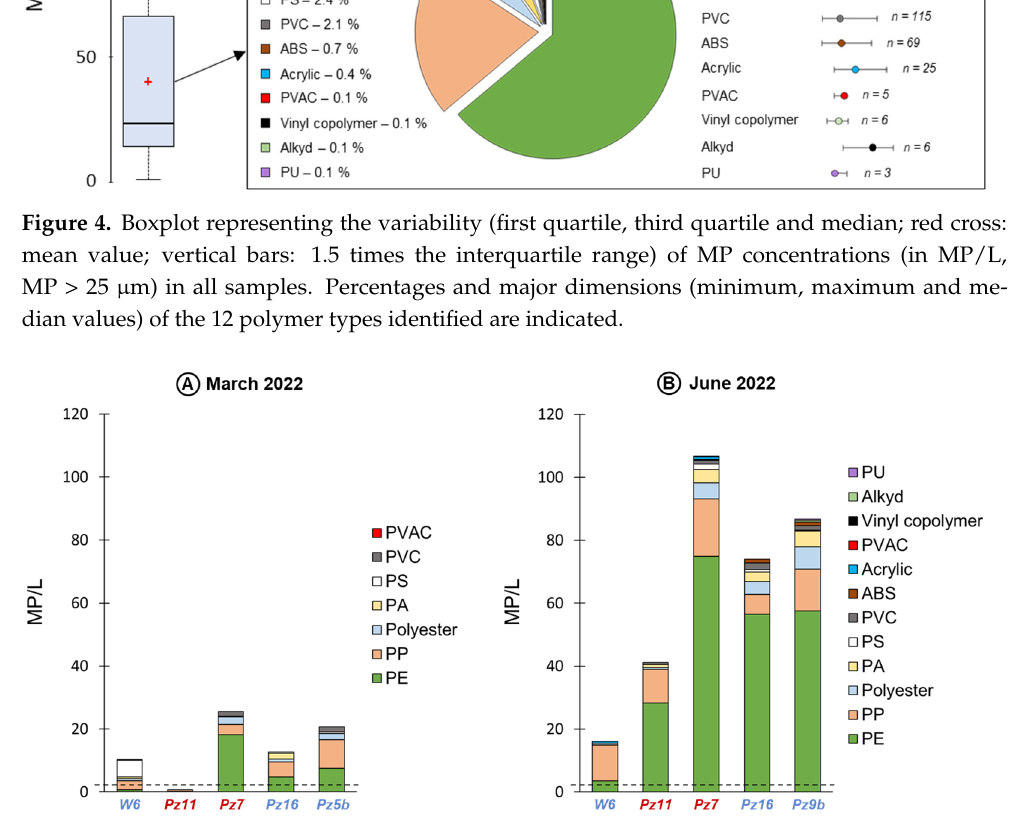
Figure 5. MP concentrations (in MP/L, MP > 25 µ m, the dotted black lines indicate field blank concentrations) and polymer types at the different sampling points in ( A ) March and ( B ) June 2022. Wells and piezometers catching the alluvial groundwater from upstream to downstream are represented in blue, piezometers catching the landfill groundwater are represented in red.